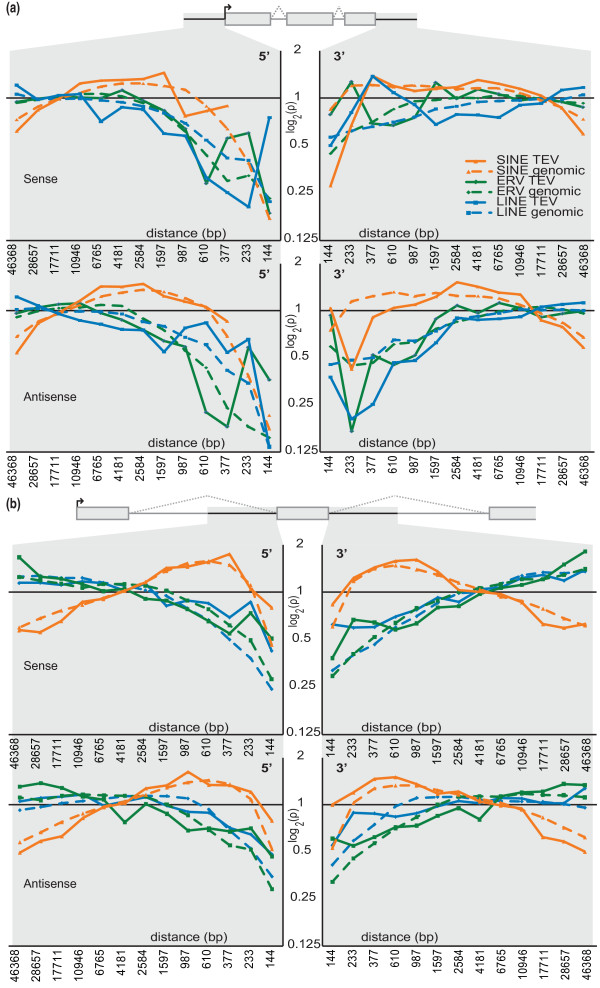
Densities of intergenic TEVs in the proximity of gene boundaries. (a) Densities of TEVs (full lines) or of TEs from the reference C57BL/6J assembly (dashed lines) 5' of genes' transcriptional start sites (left panels) or 3' of genes' transcriptional stop sites (right panels). The top two panels represent TEVs and TEs that occur in the transcriptional sense orientation, whereas the bottom two panels represent those present in the antisense orientation. For each family, the densities of TEVs (y-axis) present within distance bins (x-axis) from the gene are shown relative to the TEV density observed. Bin sizes were selected from the Fibonacci series, which allowed improved visualization of TEV densities compared to linear or logarithmic scales. All TEVs and TEs are depleted in close proximity to the 5' of genes, but SINEs are enriched upstream (approximately 500 bp to 10 kbp) of genes. No significant effects of TEV orientation on density distributions in the vicinity of genes were observed. (b) Densities of intronic TEVs in the proximity of exon boundaries. Densities of intronic TEVs (full lines) or of TEs from the reference C57BL/6J assembly (dashed lines) 5' of exons (left panels) or 3' of exons (right panels). The top two panels represent TEVs and TEs that occur in the transcriptional sense orientation, whereas the bottom two panels represent those present in the antisense orientation. For each family, the densities of TEVs (y-axis) present within distance bins (x-axis) from the gene are shown relative to the TEV density observed. Bin sizes were selected from the Fibonacci series, which allowed improved visualization of TEV densities compared to linear or logarithmic scales. A difference in density profiles of sense and antisense TEVs is observed in proximity to exon boundaries.